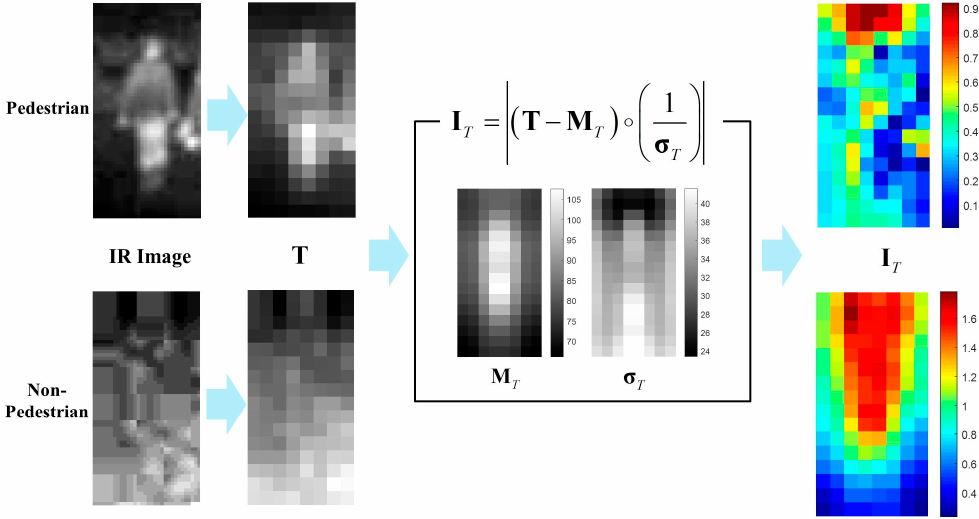
Figure 11. Example of computing I part from testing images.